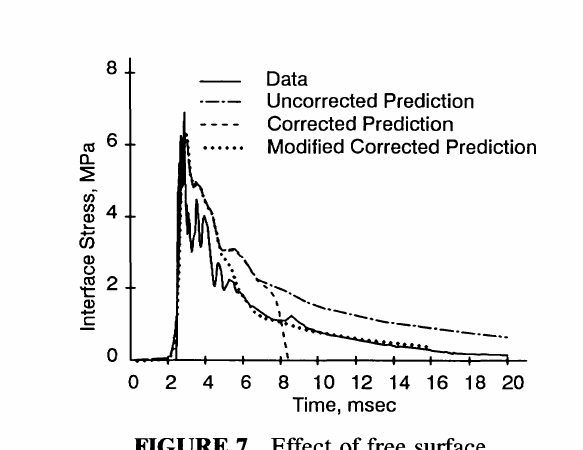
FIGURE 7 Effect of free